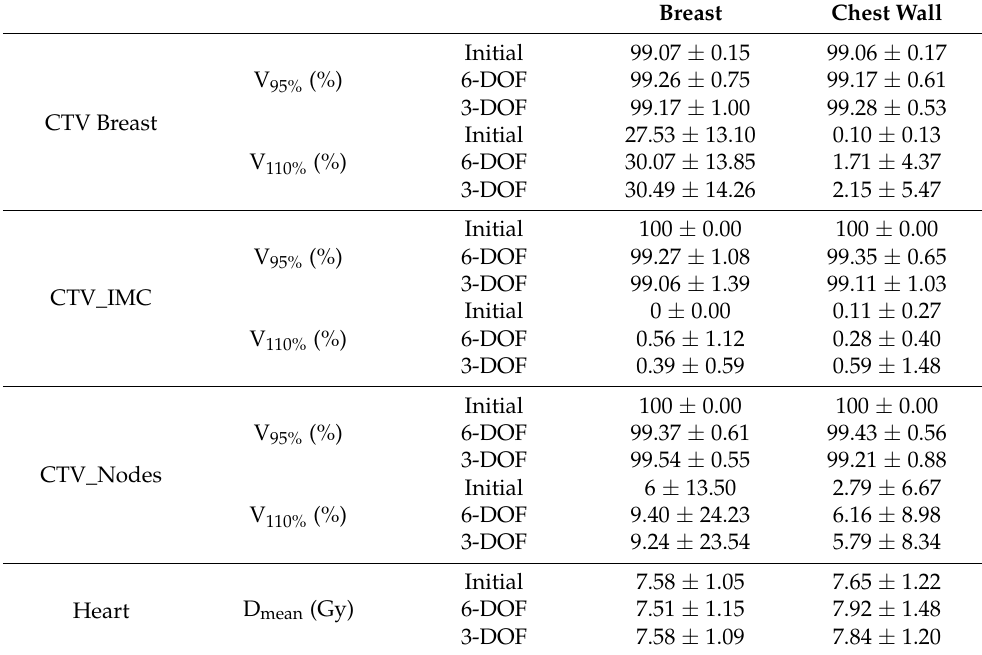
Figure 6. Dose volume histograms for the initial plan (dotted lines), and 6-DOF (dashed lines) and 3-DOF (solid lines) CBCT plans for chest wall irradiation. Table 2. Comparison of dose metrics for the initial and 3-DOF and 6-DOF CBCT treatment plans. Breast Chest